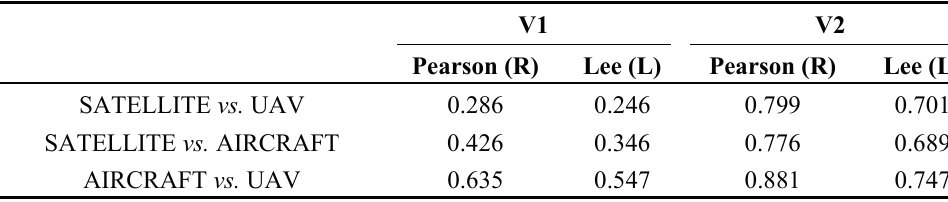
Table 3. Similarity analysis